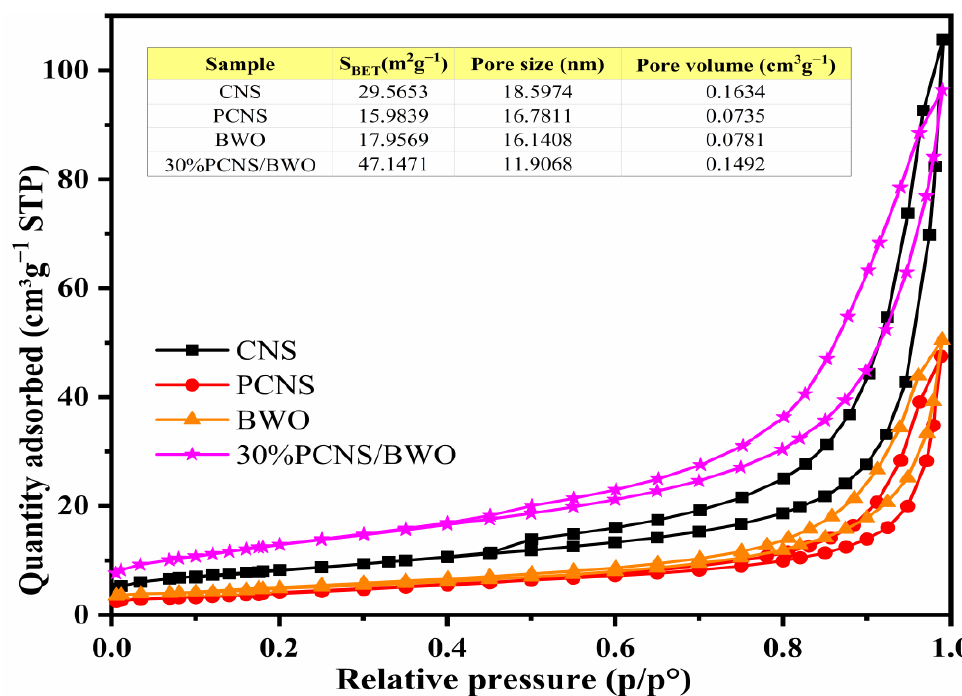
Figure 6. N 2 adsorption/desorption isotherms of CNS, PCNS, BWO, and 30% PCNS/BWO.